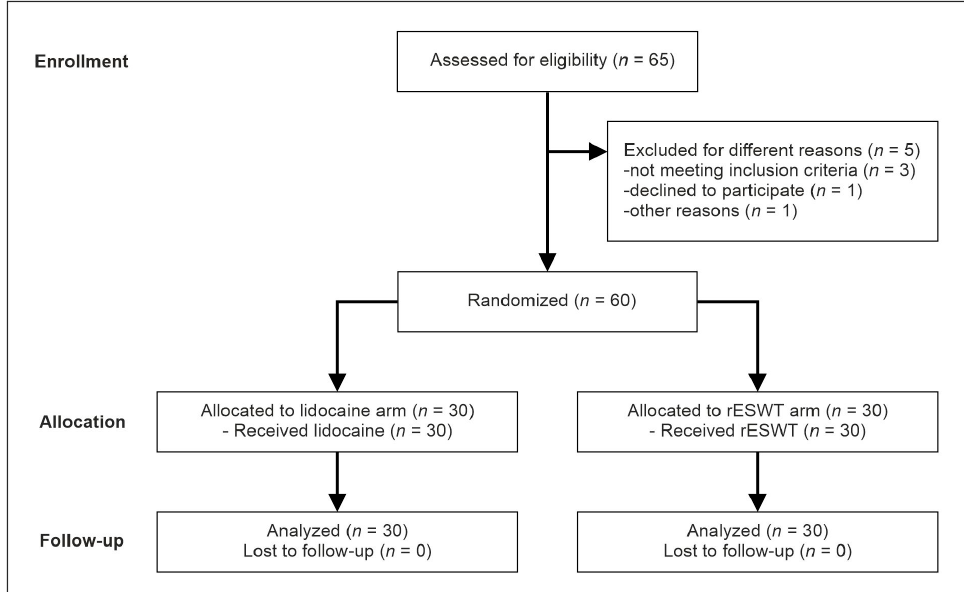
Figure 1. Flow of patients through this study according to CONSORT [39]. Injections of lidocaine and rESWT were administered by a single, skilled physiatrist (A.S.). PPT) and the neck disability index (NDI) were blinded to group randomization, and did not about the group